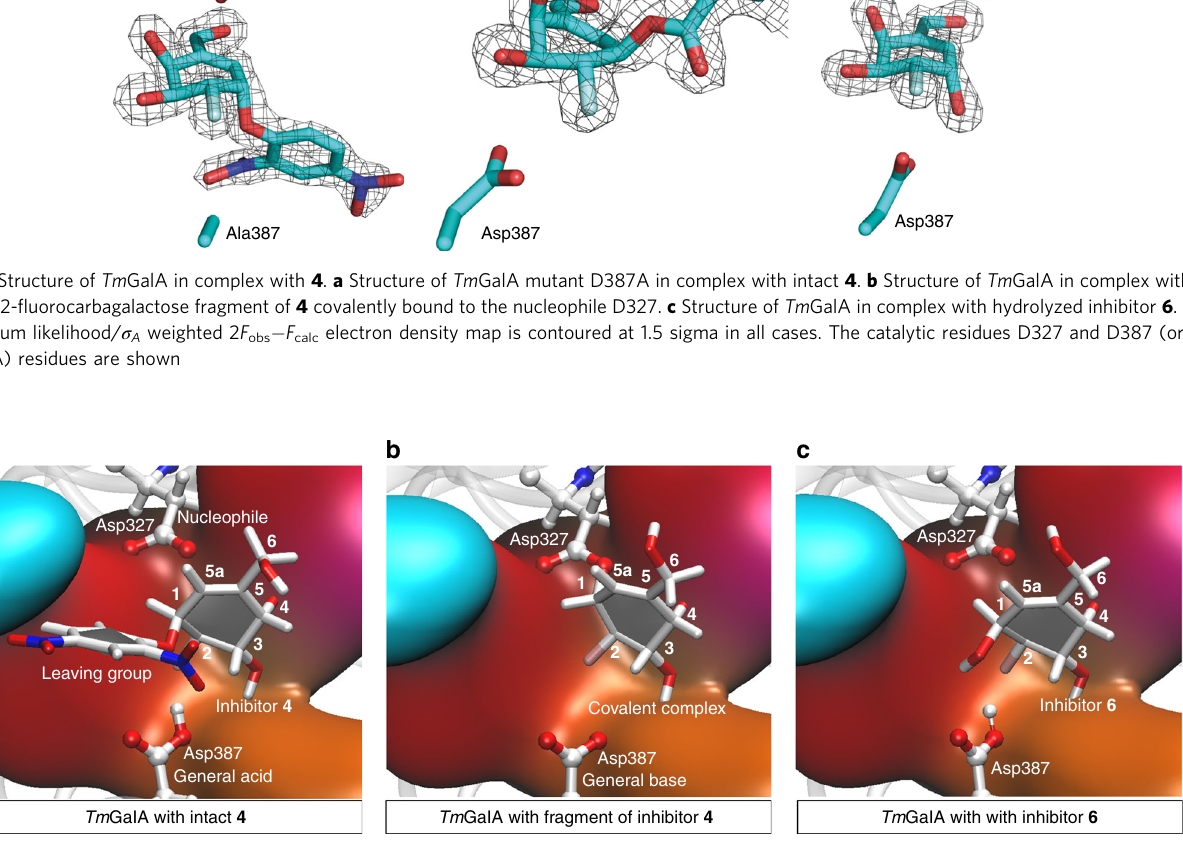
Fig. 7 Structural snapshots of the active site of Tm GalA. The enzyme's active site is shown in complex with: a 4 (or E:I ); b 2-deoxy-2- fl uorocarbagalactose fragment of 4 covalently bound to the nucleophile Asp327 (or E-I ) and c hydrolyzed inhibitor 6 (or E:P ). Structures were optimized at DFT/MM level